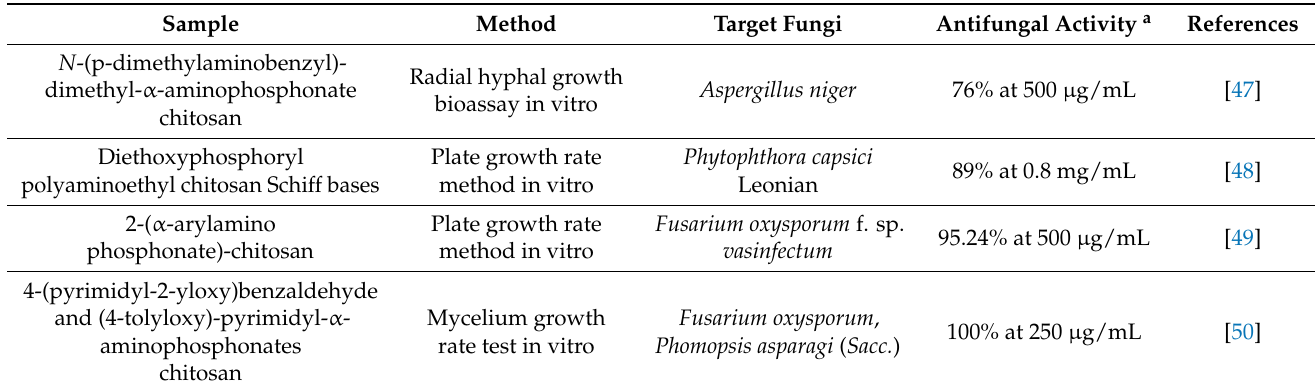
Table 2. Antifungal properties of some phosphorylated chitosan